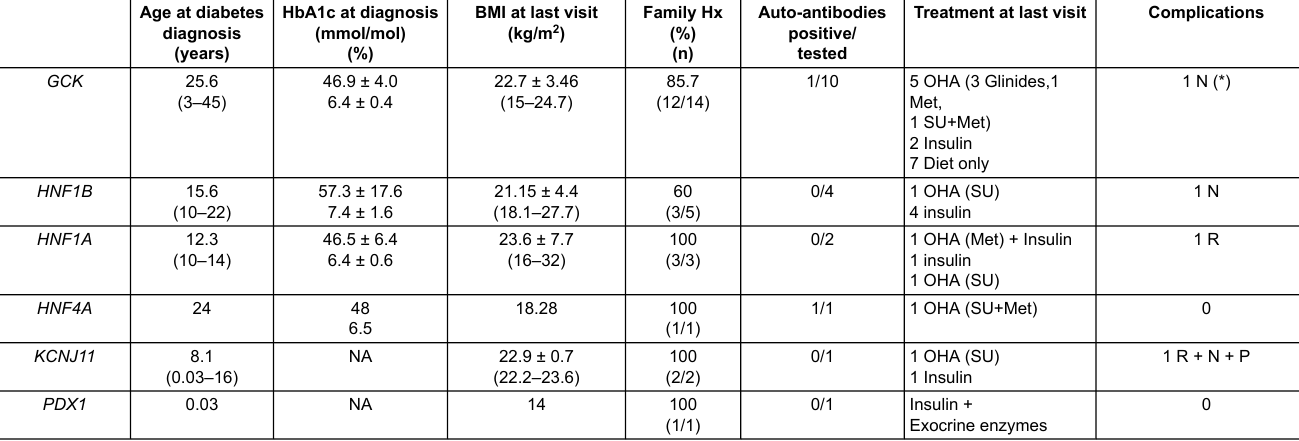
Table 2a: Subject characteristics according to genotype.